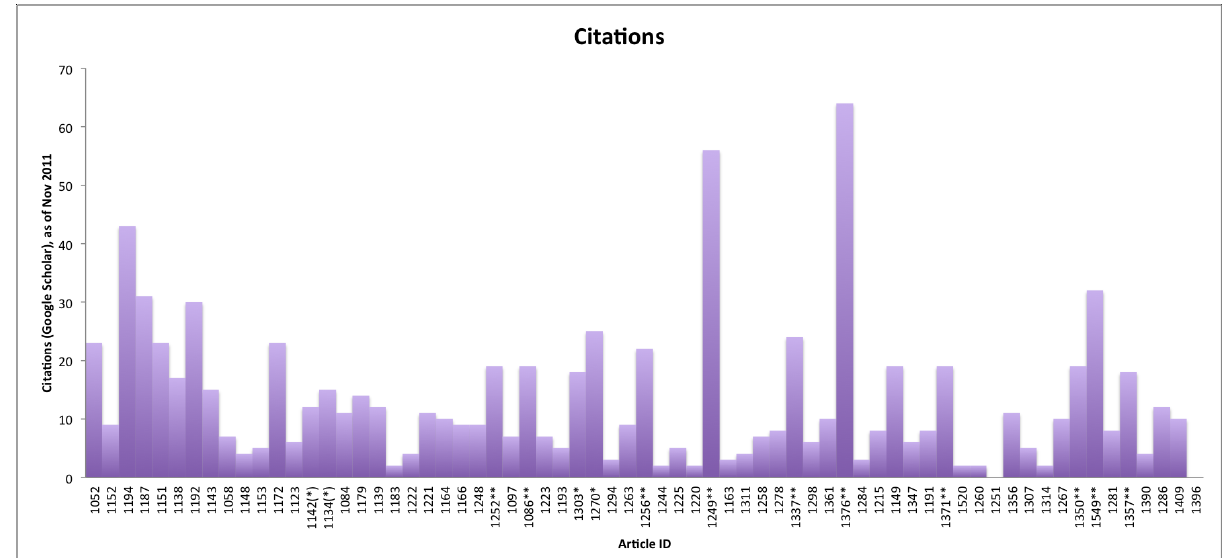
Figure 8. Google Scholar citation counts for all articles published between issue 3/2009 and issue 2/2010. Top-cited articles (75th percentile) within each issue are marked ** (top cited according to Google Scholar and Scopus), * (Google Scholar only), or (*) (Scopus